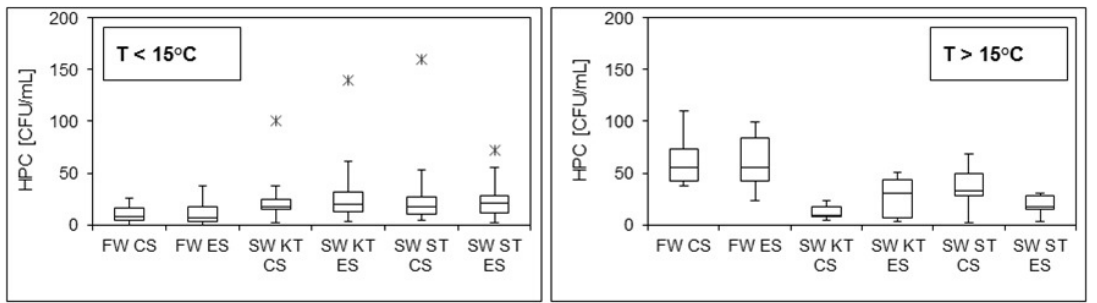
Figure 4. HPC levels in fresh water (FW) and stagnant water (SW) in the conventional (CS) and extended (E-S) system at the kitchen tap (KT) and shower tap (ST). Number of fresh samples (inlet, kitchen and shower) = 48. Left : Temperature of fresh water < 15 °C, number of fresh samples = 33, number of stagnant samples per tap = 11. Right : Temperature of fresh water >15 °C, number of fresh samples = 15, Number of stagnant samples per tap = 5; SD < 5%, * —outliers.